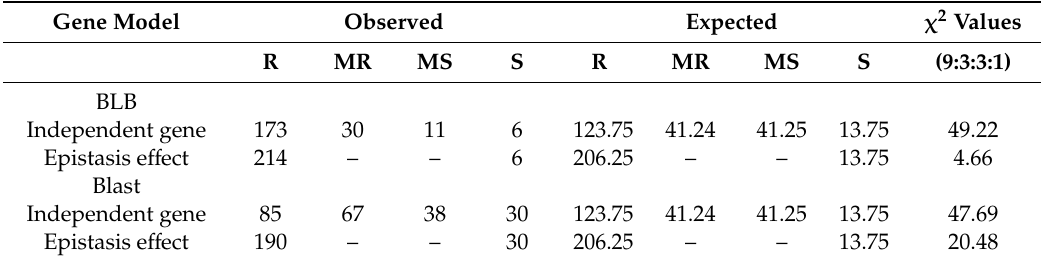
Table 6. Chi-square test for independent genes (9:3:3:1) and epistasis e ff ects (15:1) for BLB and blast resistance in BC 2 F 2 population inoculated with the most virulent pathotype P7.7 and P7.2 of Xoo and Magnaporthe oryzae